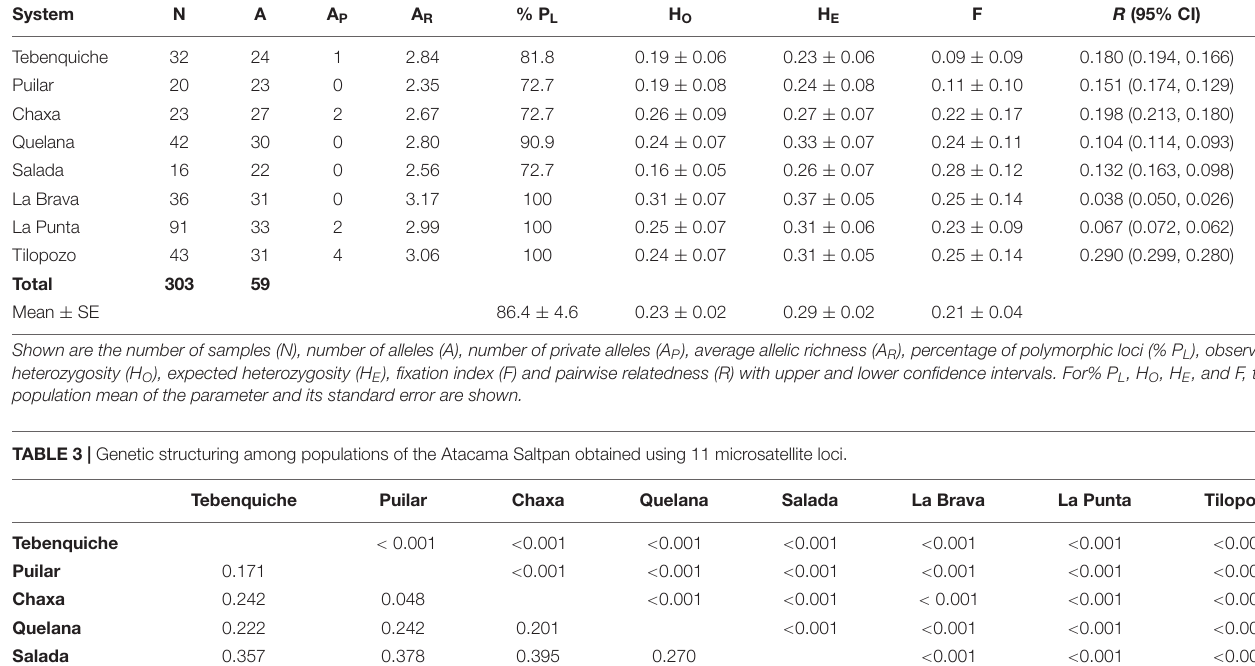
TABLE 2 | Genetic diversity parameters determined from the analysis of the 11 microsatellite loci of eight populations of H. atacamensis . System